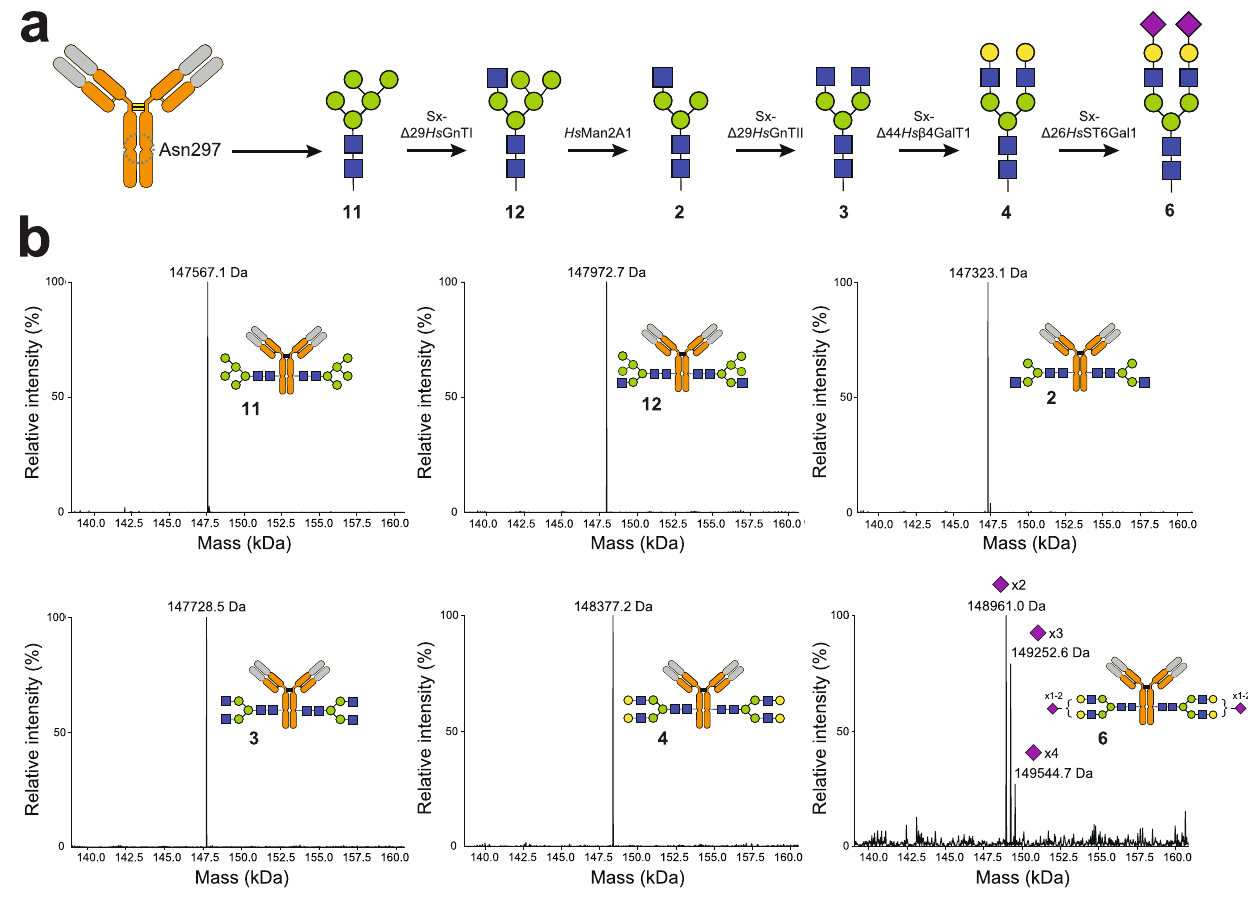
Fig. 5 | Remodeling of IgG-Fc N -glycans on trastuzumab using Sx-GTs. a Schematic of bioenzymatic routes to hybrid- and complex-type N- glycan struc- tures linked to asparagine 297 (N297) of the trastuzumab antibody. Trastuzumab bearing Man 5 GlcNAc 2 glycan (M5; glycan 11) derived from glycoengineered HEK293F lacking GnTI activity was used as a glycan primer. Subsequent cell-free glycan remodeling reactions yielded the following N -glycan structures: 12 (M5+GlcNAc);2 (G0-GlcNAc); 3 (G0); 4 (G2); and 6 (G2S2).Glycan notation